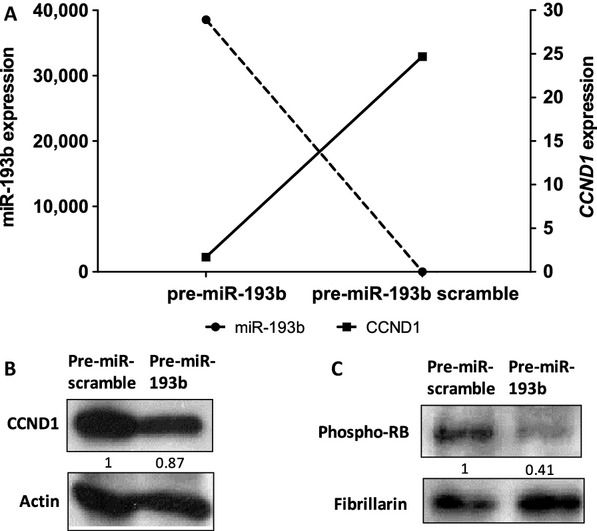
miR-193b overexpression reduces the expression of CCND1, the level of Cyclin D1 protein and phosphorylation level of retinoblastoma (RB). 22Rv1 prostate cancer cells were transfected with pre-miR-193b or pre-miR-control. (A) Expression levels of CCND1mRNA was measured using q-RT-PCR. Western blot analysis was used to detect protein expression of (B) Cyclin D1 from total proteins and (C) phosphorylation level of RB protein from nuclear protein fraction. Actin and fibrillarin antibodies were used as loading controls.